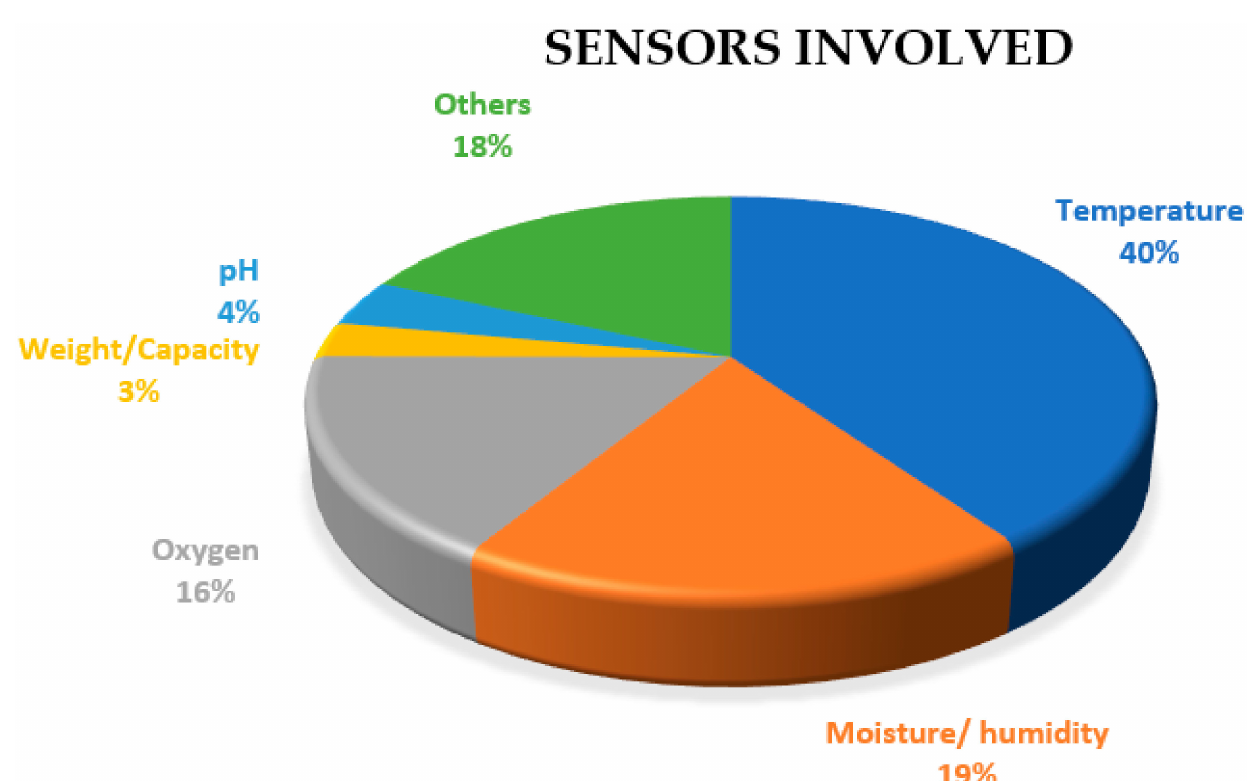
Figure 16. Sensors involved within the selected